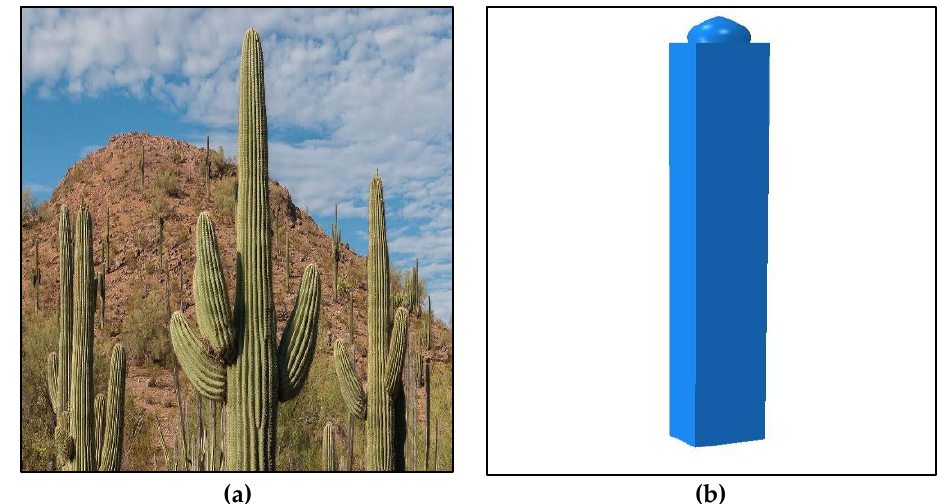
Figure 4. ( a ) Saguaro Cactus plant. ( b ) Proposed mimicked shape in column.